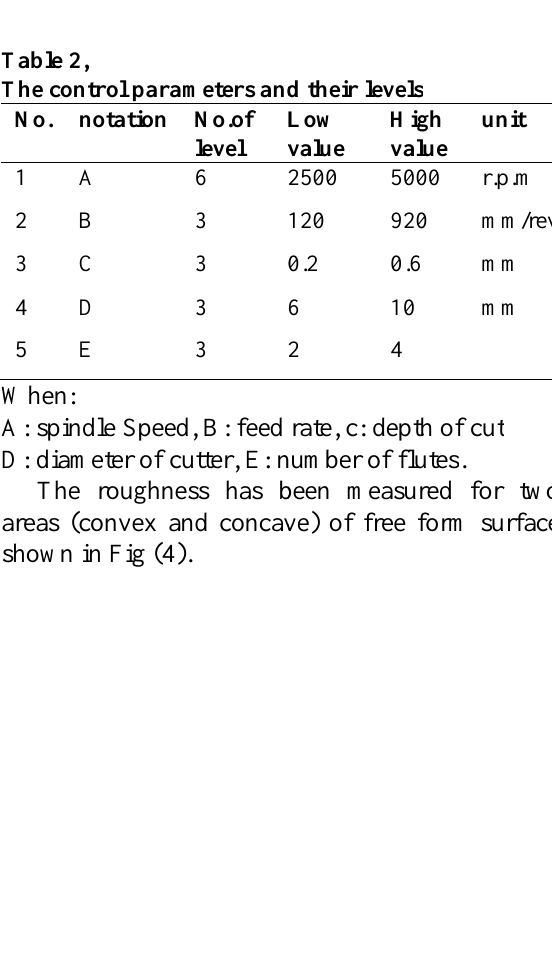
The control parameters and their levels No.